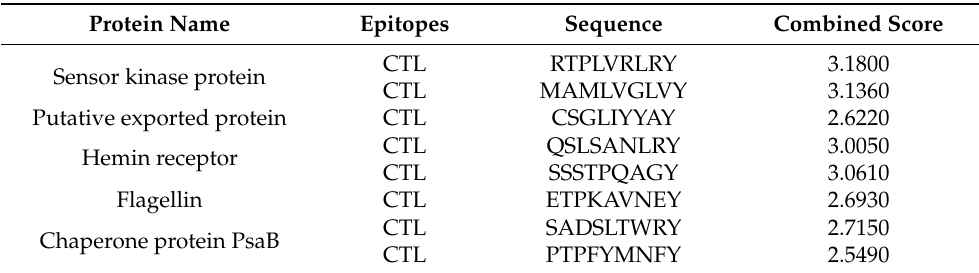
Table 2. The shortlisted CTL epitopes for each protein with the combined scores predicted by NetCTL server.